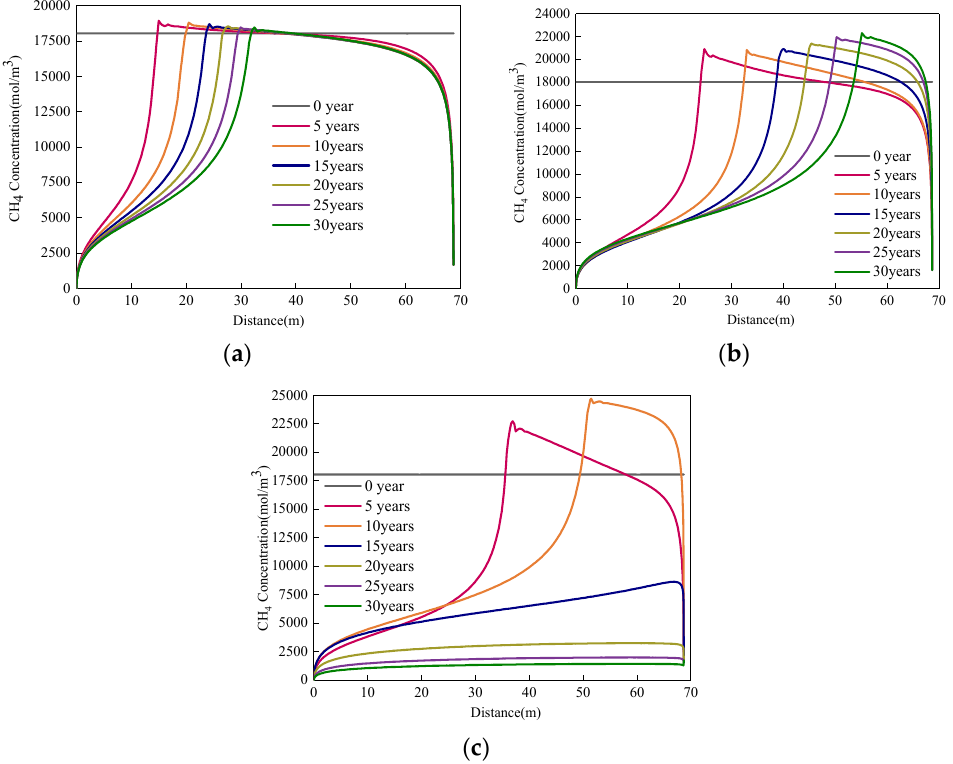
Figure 4. Distribution of diagonal CH 4 molar concentrations at different injection pressures: ( a ) injection pressures is 4 MPa; ( b ) injection pressures is 6 MPa; and ( c ) injection pressures is 8 MPa.